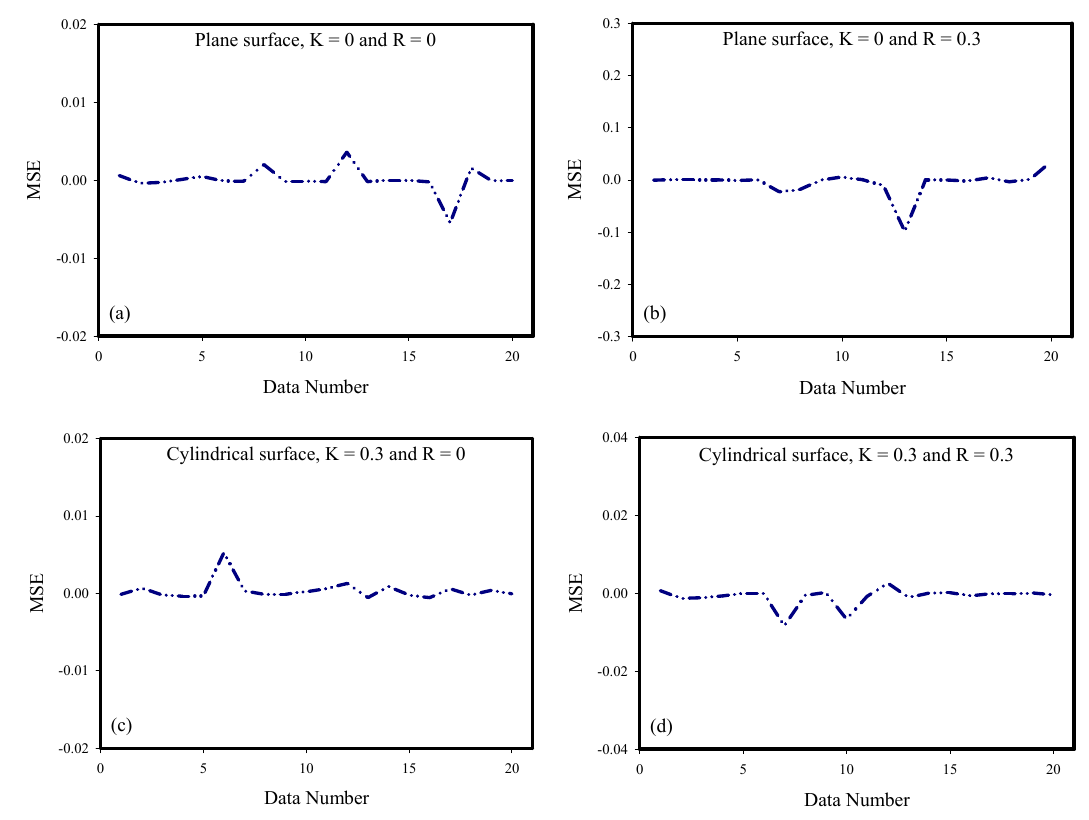
Figure 7. MSE values for thermal Flow Regimes-I ( a ), -II ( b ), -III ( c ), and -IV ( d ) according to the number of data used in the training phase.